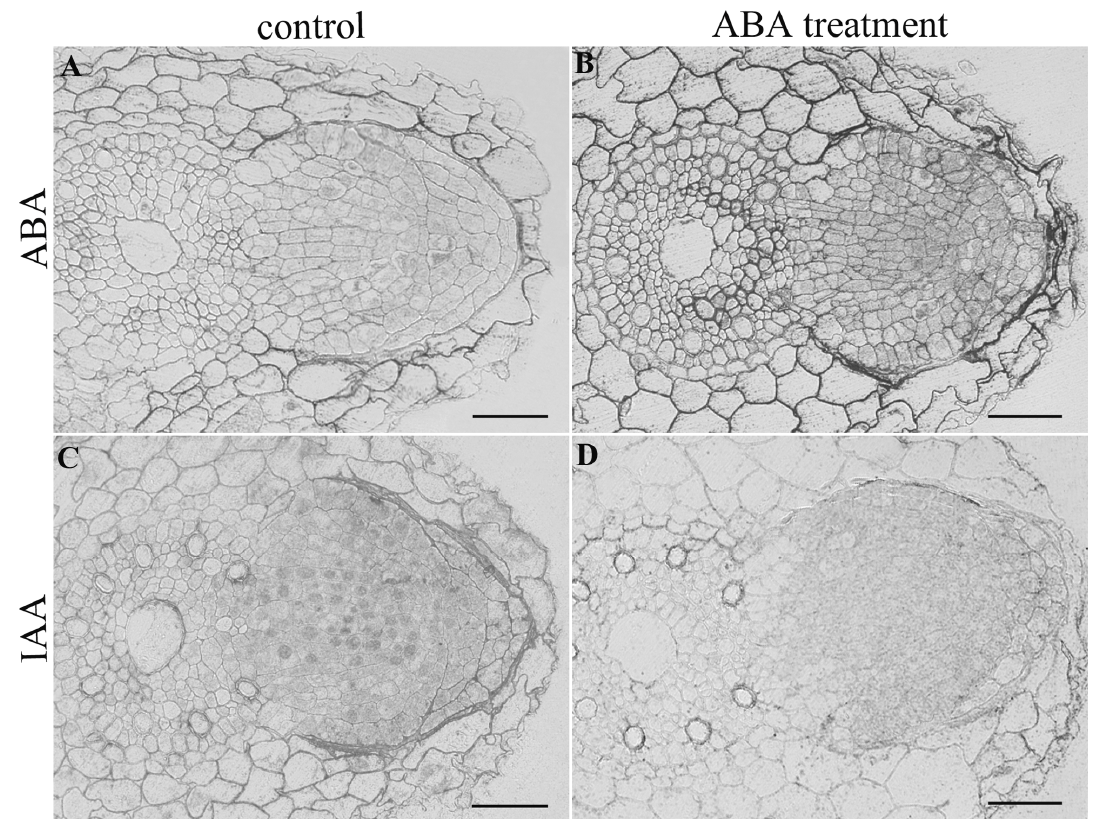
Figure 8. Effect of 0.1 mg/L ABA treatment on immunolocalization of ABA ( A , B ) and IAA ( C , D ) in the cells of root primordia of ABA–deficient Az34 barley plants. ( A , C )—plants grown under normal conditions; ( B , D )—plants grown under ABA treatment for 3d. Scale bar is 50 µm.